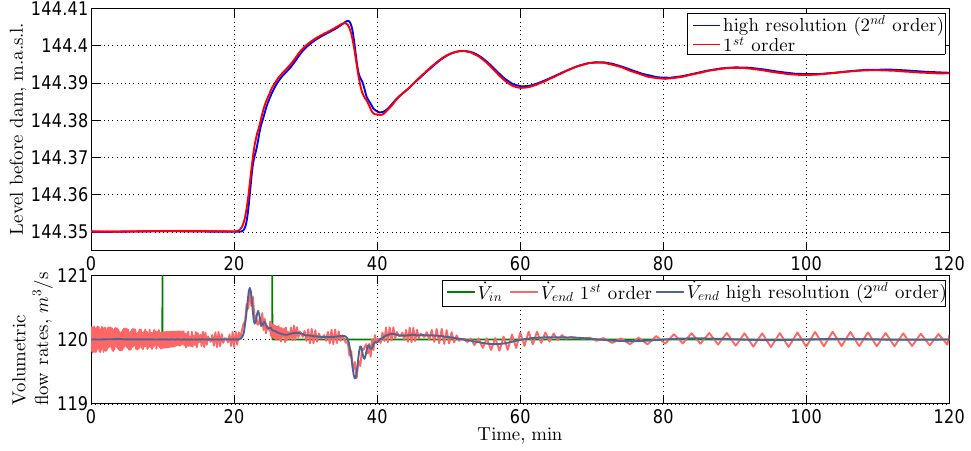
Figure 7: The results of simulating the model with two methods, using the ode23t solver.